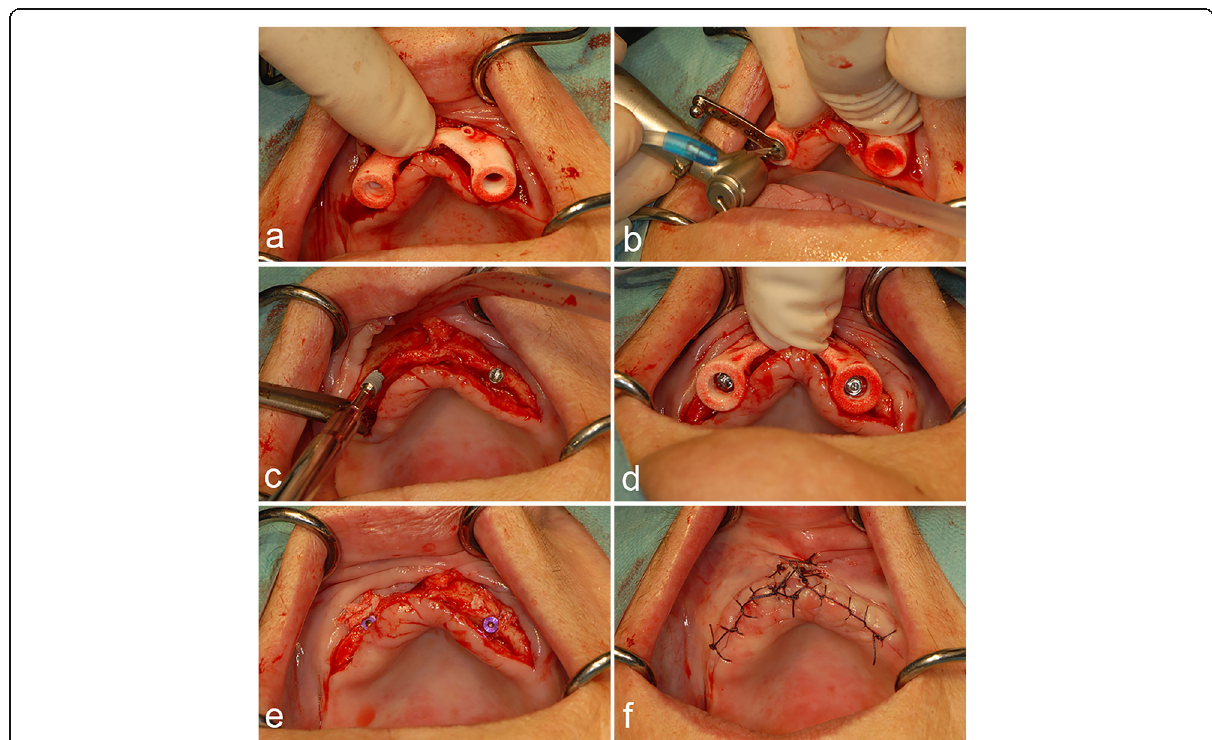
Fig. 3 Surgical procedure. a The template is positioned by placing it on the alveolar ridge. Then, the two brackets are rotated onto the nasal notch. b The implant beddings are prepared using the manufacturer ’ s sleeves. c After preparation, the implants are manually placed at 45 N cm. Notice the thin atrophic alveolar crest. d The implants are positioned according to the template. e The cover screws are placed. f The wound is sutured with a non-resorbable material